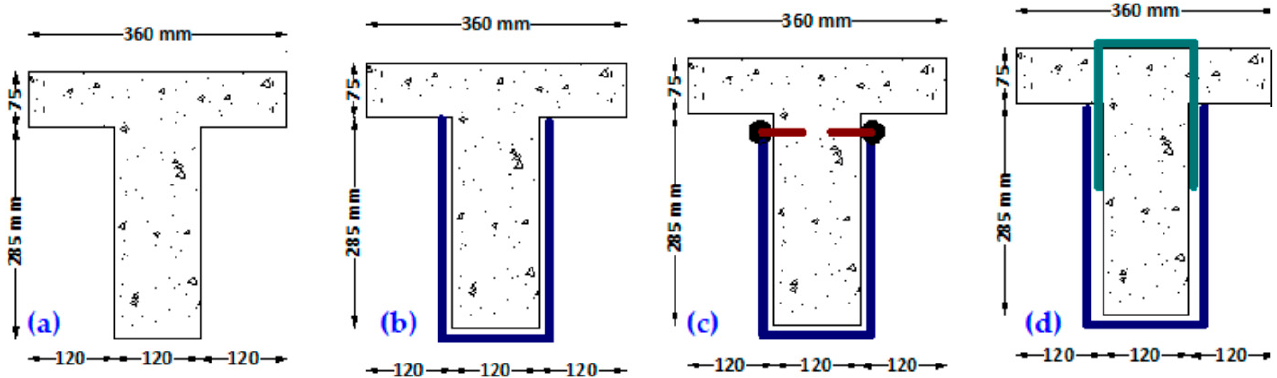
Figure 7. ( a ) Force transfer mechanisms for externally bonded CFRP strips for shear retrofit and the concept of forming a “unit T-beam” specimen. ( b ) Three-dimensional drawing of a limited length unit “T-beam” specimen including a single CFRP strip external transverse shear reinforcement with a steel anchoring device together with the externally applied load.